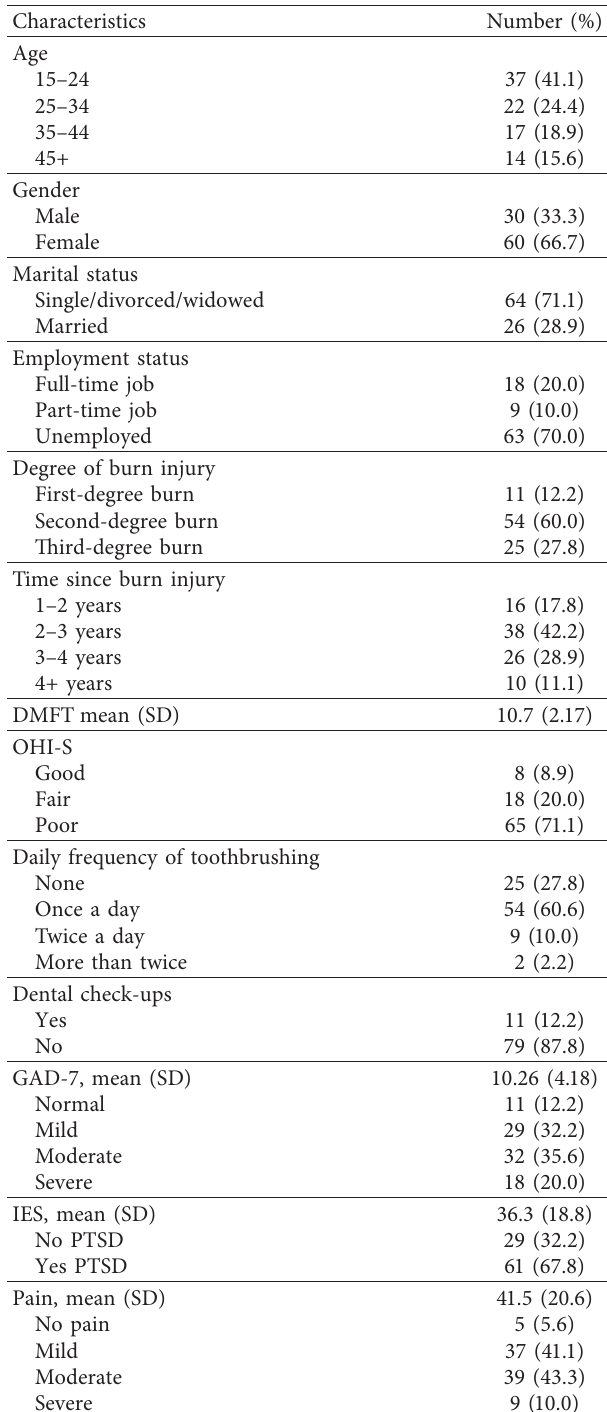
Table 1: Sociodemographic characteristics of the participants ( N �